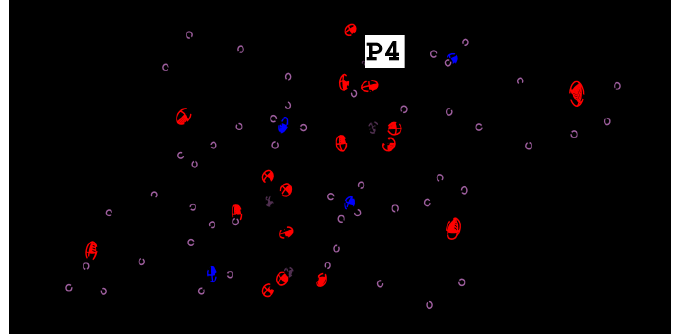
Figure1. ORTEP View of the asymmetric unit of [3-(CH